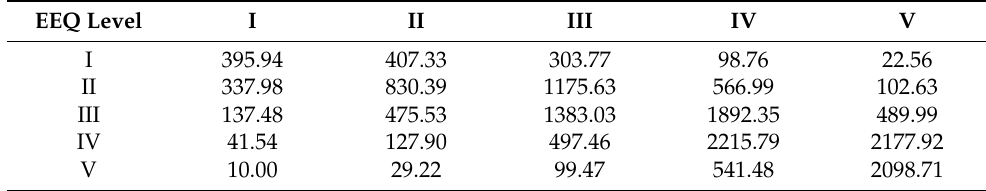
Table 2. The transition matrix of EEQ levels during 2015–2020.